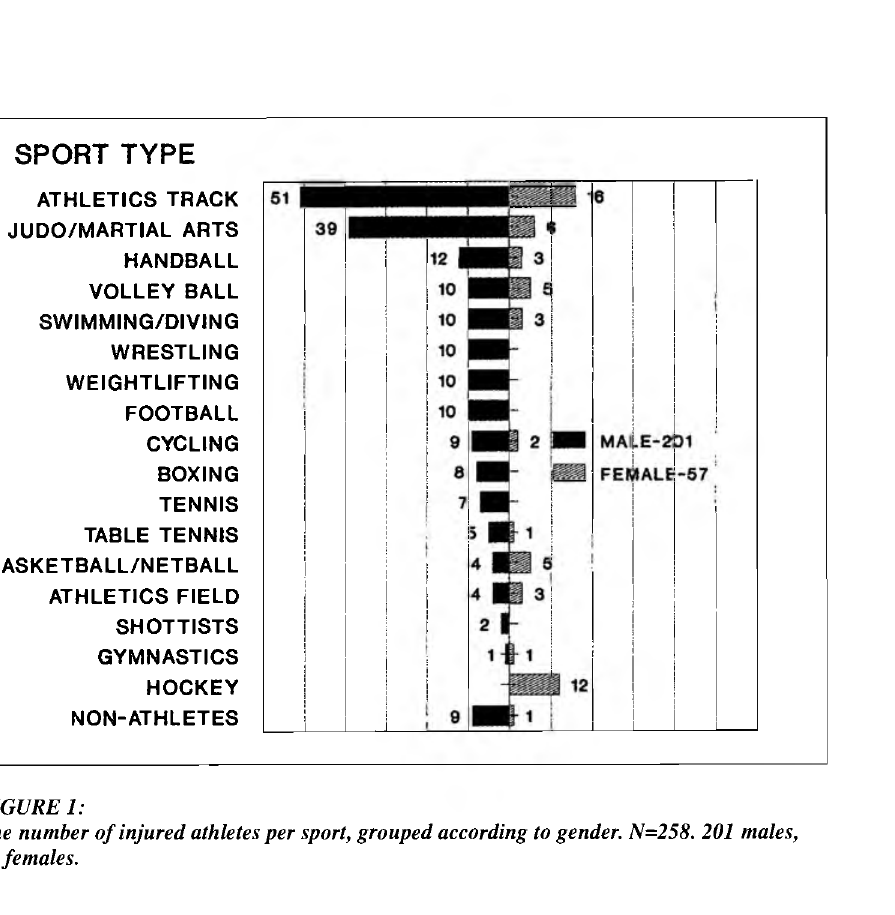
FIGURE 1: The number of injured athletes per sport, grouped according to gender. N=258. 201 males, 57 females.